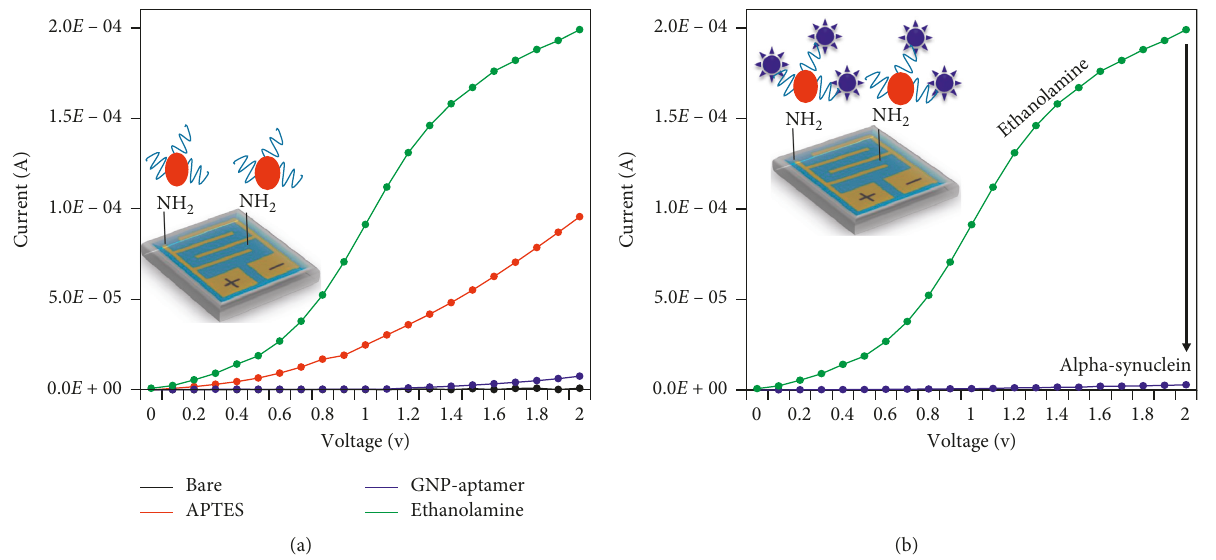
Figure 4: (a) GNP-aptamer immobilization on the IDE sensing surface. The IDE surface was modified by APTES. The GNP-aptamer was immobilized, and the remaining surfaces were blocked by ethanolamine. (b) Alpha-synuclein detection on a GNP-aptamer-modified IDE sensing surface. A schematic representation is shown in the figure inset.